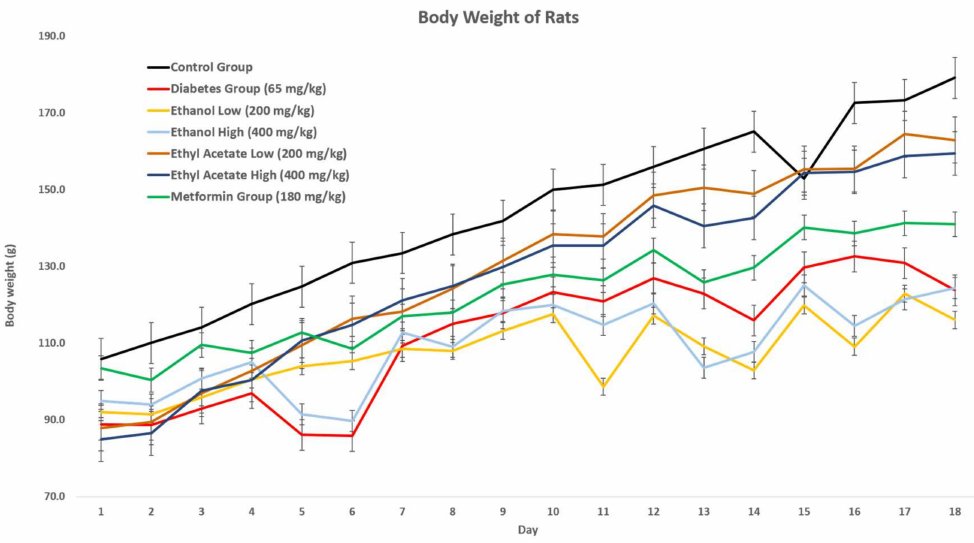
Figure 1. Effect of P. tetrastromatica extracts on the body weight of diabetes-induced rats.